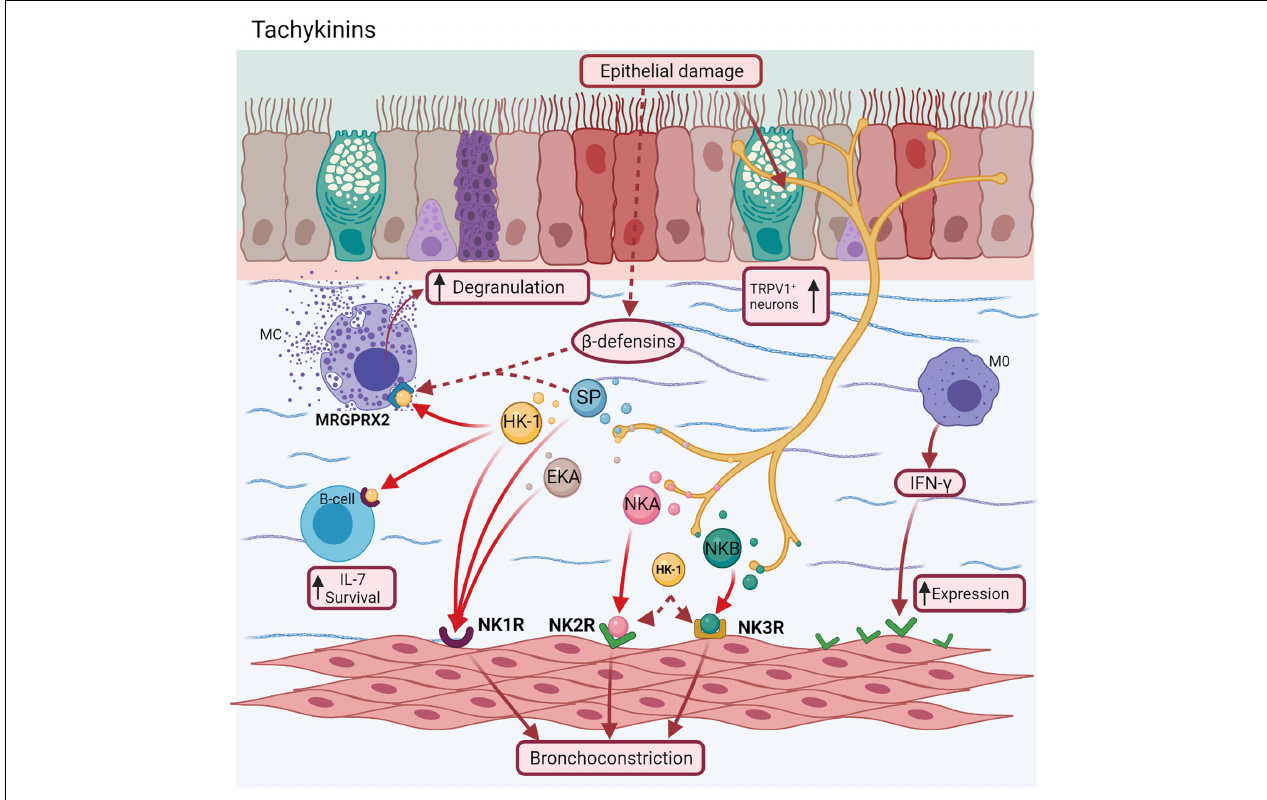
FIGURE 5 | Tachykinins. Neurokinin A (NKA) and Neurokinin B (NKB) bind to NK2R and NK3R receptors, respectively, whereas Hemokinins (HK-1), Endokinins (EKA/B), and SP bind to NK1R. However, SP, NKA, and NKB can couple to all receptors, localized mainly in airway smooth muscle inducing